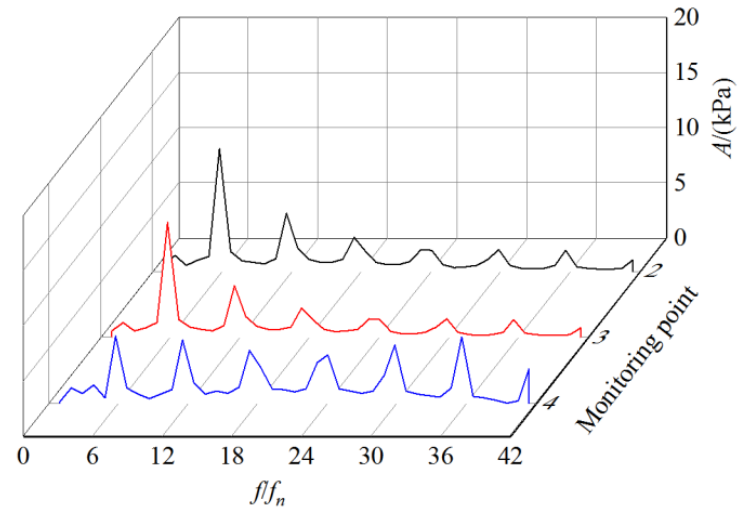
Figure 12. Frequency domain of pressure fluctuation at volute radial location (curves 2, 3 and 4 represent frequency domain curves at monitoring points 2, 3 and 4 respectively).